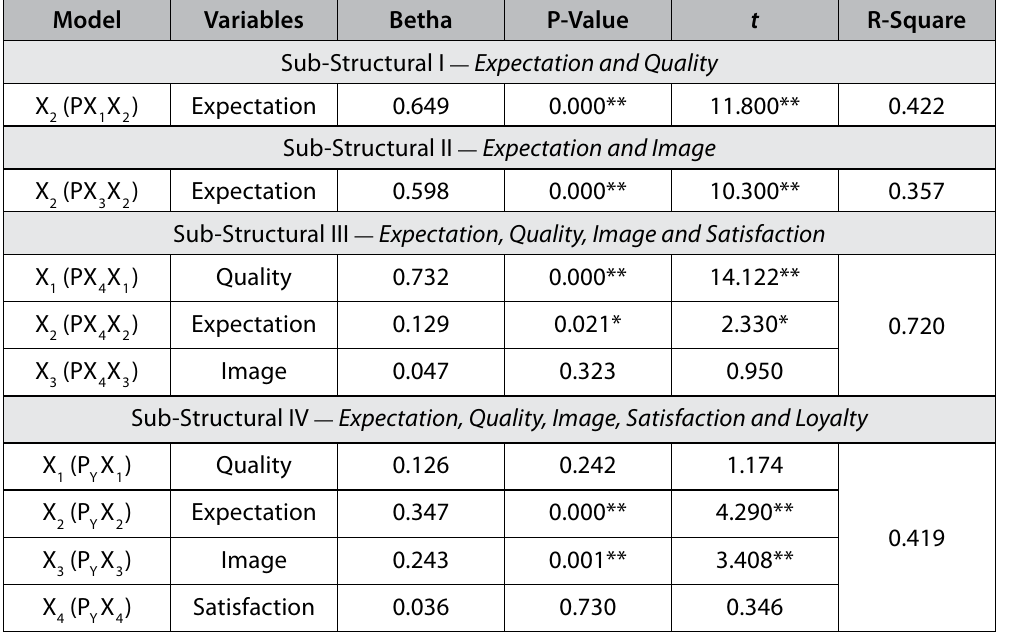
Table 4 Path analysis results prior to